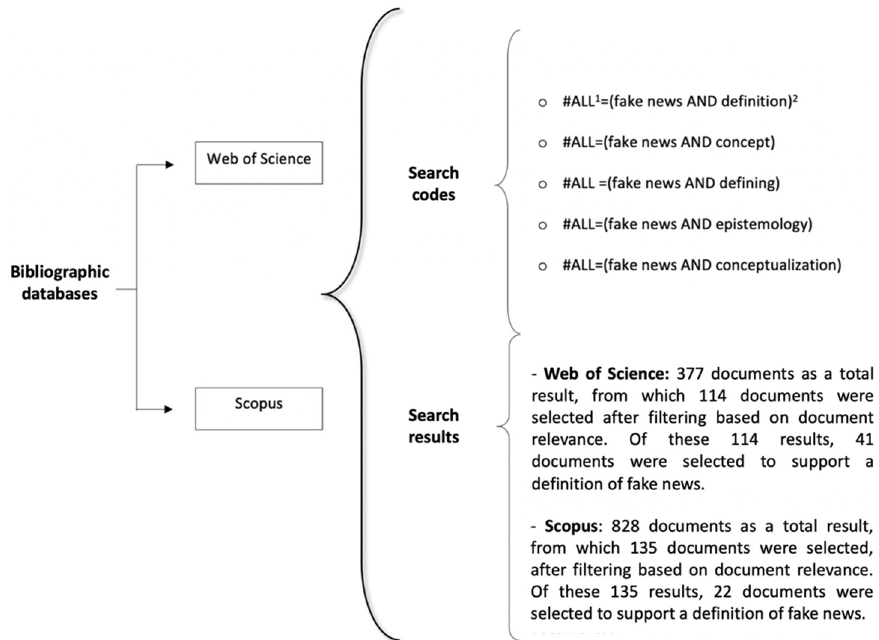
Figure 1. Methodological design to conceptualize fake news. Note: 1 All languages, key terms searched in all documents, titles, abstracts, and keywords; 2 Scopus results were limited to social sciences. The documents from the Scopus database were consulted later, which implied that some results had already been considered in a first analysis of the Web of Science database.